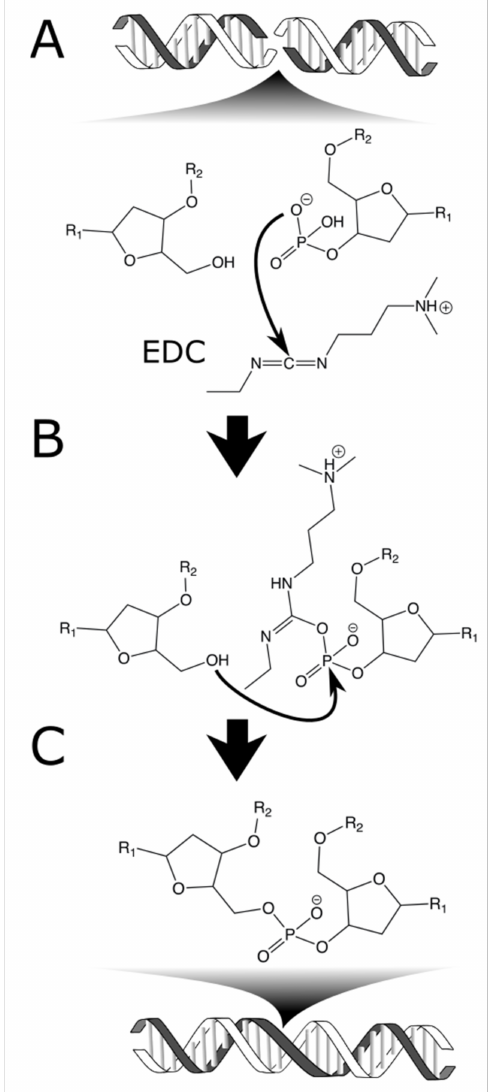
Figure 1. The mechanism of chemical DNA ligation with EDC. ( A ) A terminal 5 (cid:48) hydroxyl and a terminal 3 (cid:48) phosphate on neighboring DNA chains. The phosphate interacts with EDC to form an intermediate ( B ) and the hydroxyl displaces the reactive intermediate to form a zero-length crosslink ( C ) between the two DNA chains. R 1 is the nucleobase and R 2 is the phosphate